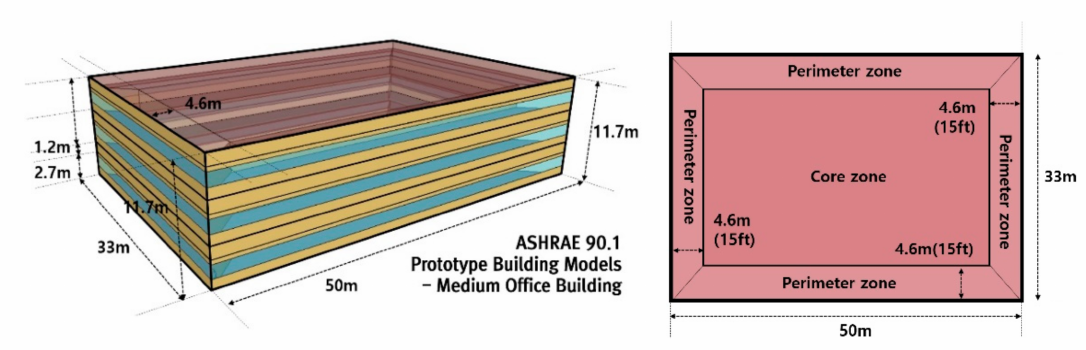
Figure 3. Simulation base